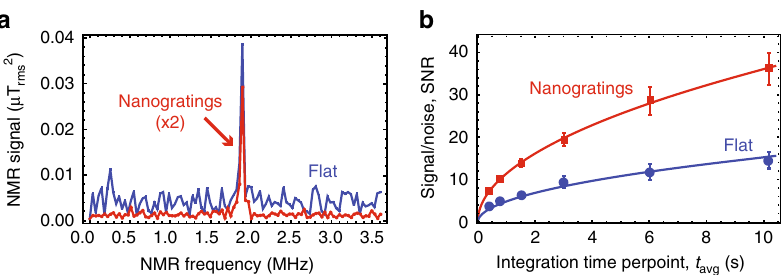
Fig. 4 NV NMR sensitivity characterization. a 19 F NMR signal from Fomblin ® oil at B 0 = 47.1 mT for fl at and nanograting sensors implanted at 20 keV using XY8-13 correlation sequence. b NMR signal-to-noise ratio as a function of averaging time. Fits to the function SNR = α sensors ( solid lines ). The coef fi cient α was 2.4 times larger for the nanograting chip. Error bars represent standard error of the mean